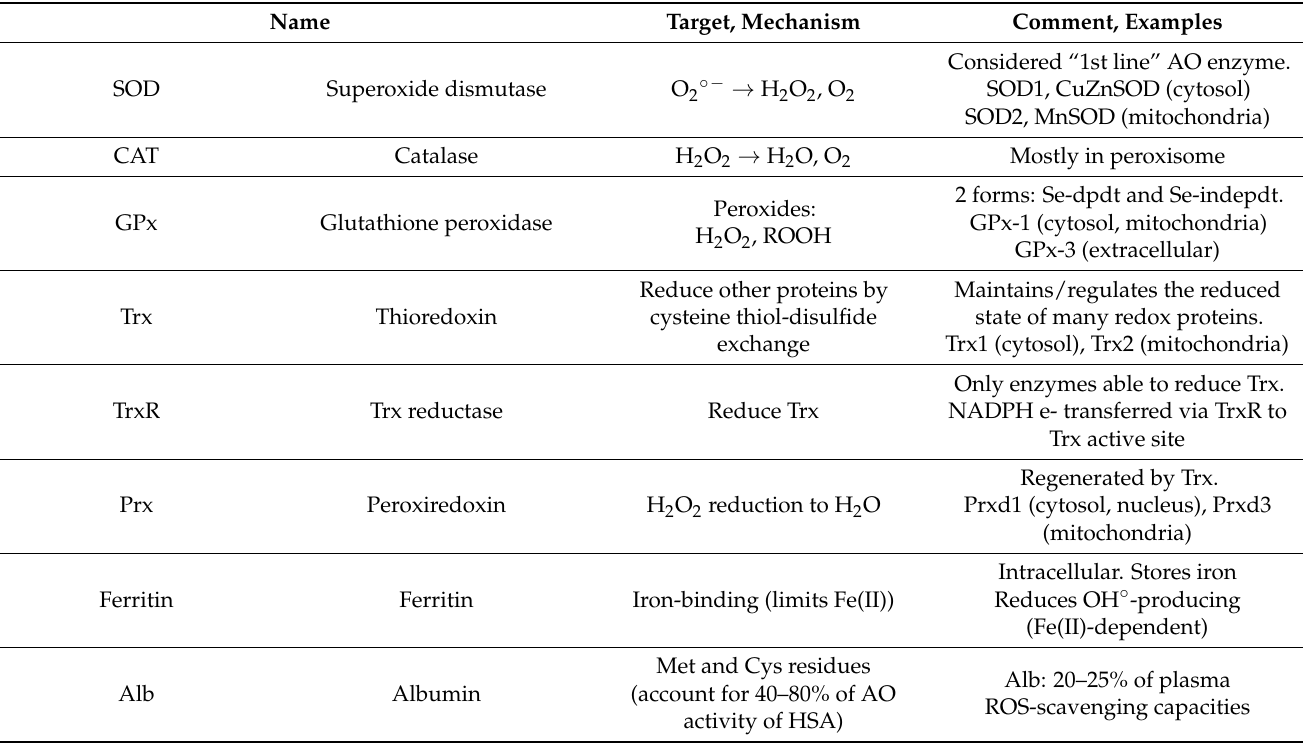
Table 2. A selection of enzymatic and protein antioxidant